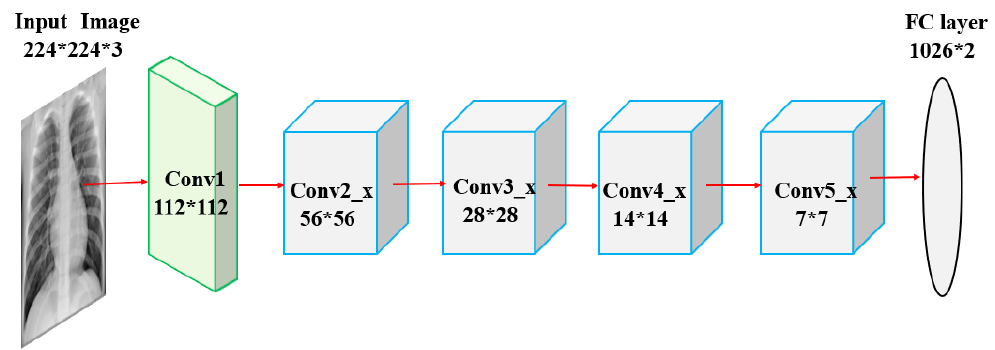
Figure A1. ResNet18 architecture comprised of a convolutional (112*112) layer at the beginning and five convolutional blocks.